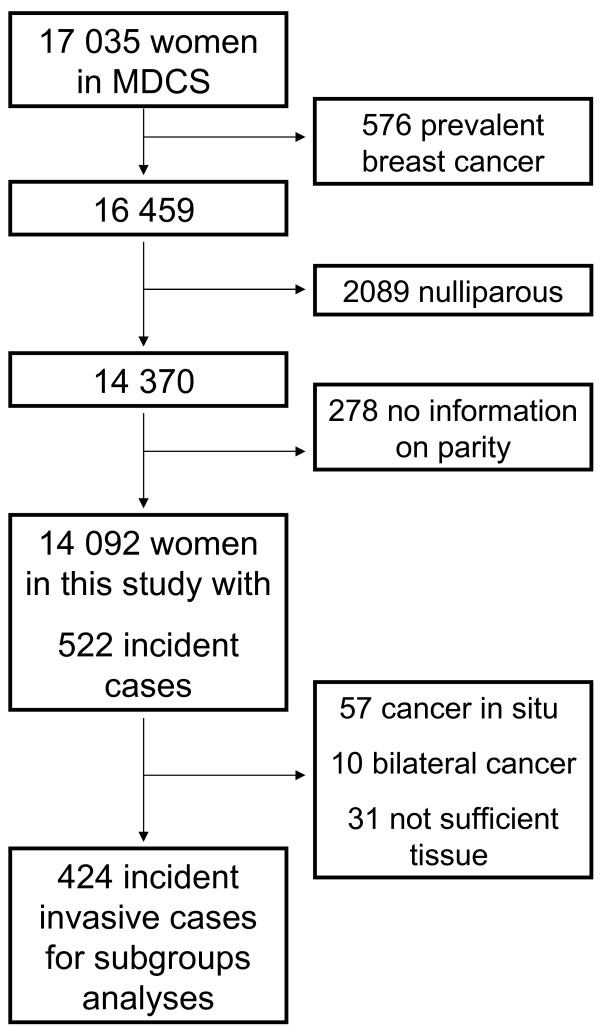
Study population (MDCS).